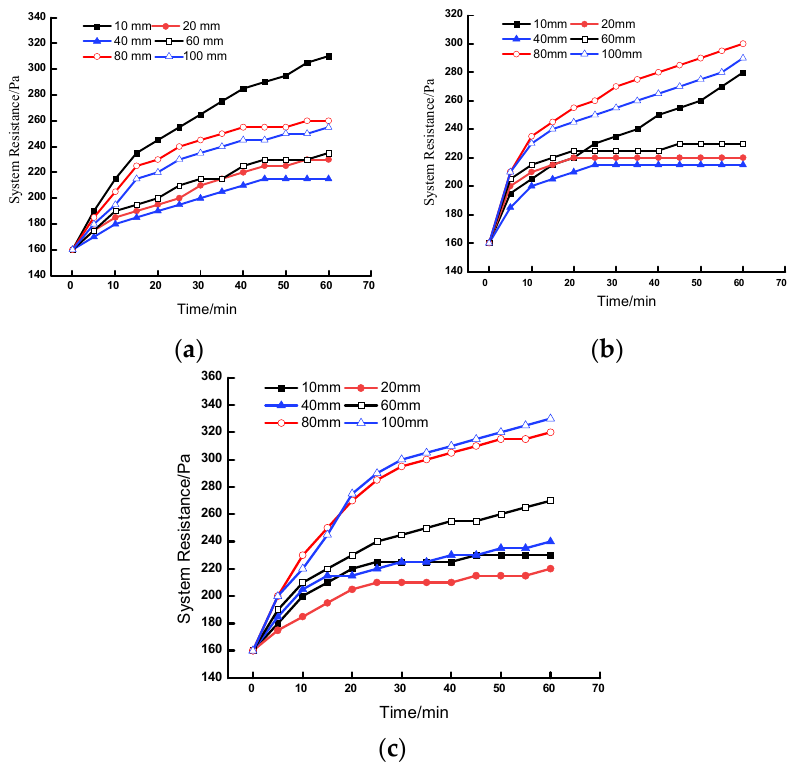
Figure 7. The change in the system operation resistance of the flat cartridge with different nozzle areas and different jet distances at the pulse pressure of 0.3 MPa. ( a ) Total nozzle area of 273 mm 2 . ( b ) Total nozzle area of 546 mm 2 . ( c ) Total nozzle area of 819 mm 2 . It shows that the flat cartridge has small system operation resistance, not more than 350 Pa. It can also be seen from Figure 7a that the cartridge had the lowest operation resistance at the jet distance of 40 mm and the operation resistance of the cartridge plateaus within 45 min at different jet distances. At the jet distance of 10 mm, the system operation resistance was large and rising. According to the pulse jet test results, P 4 had low peak pressure at the jet distance of 10 mm, so the cleaning uniformity was poor.